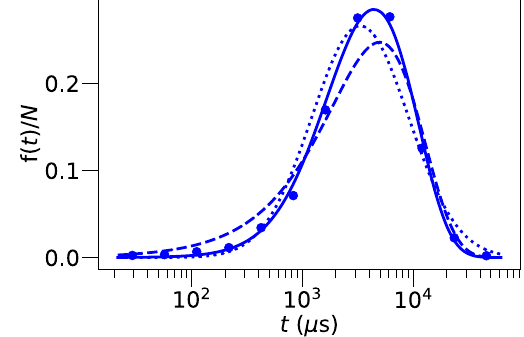
FIG. 6. Histogram of the time interval between current spikes for an electric field of 39 . 6 MV = m, from series D. The time intervals are divided logarithmically into thirteen bins, and the frequency axis is normalized by the total number of samples. The circles represent the experimental results (with error bars that are smaller than the size of the symbols), and the lines represent best fits to hypoexponential (solid), exponential (dashed), and log- normal (dotted) distributions. The logarithms of the likelihood ratios are ln ð L h =L e Þ ¼ 227 for the hypoexponential and expo- nential fits, and ln ð L h =L l Þ ¼ 466 for the hypoexponential and log-normal